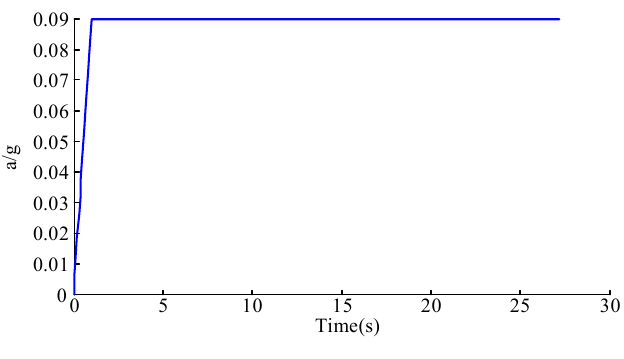
Figure 9. Brake intent from the driver.